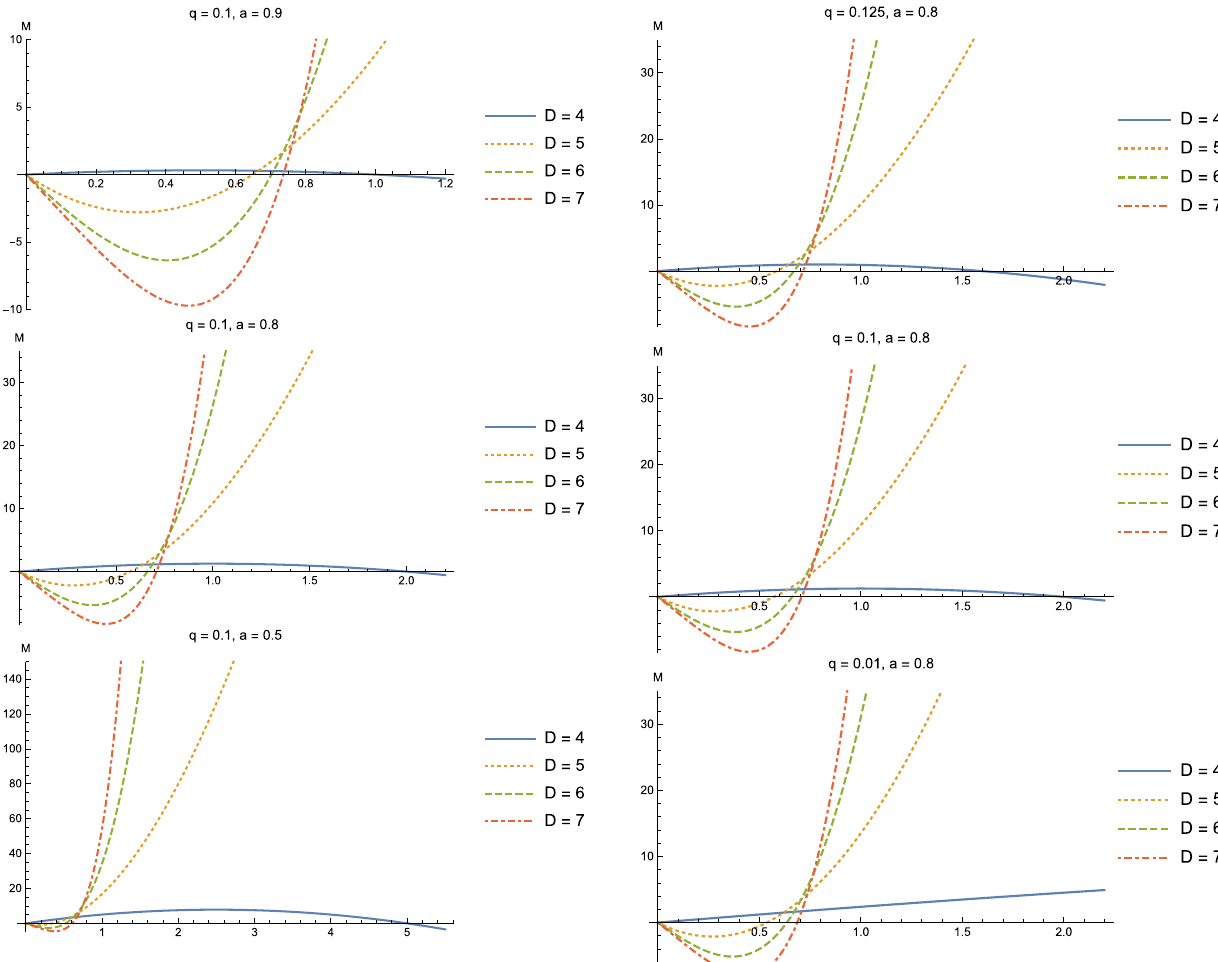
Fig. 5 Mass of black holes in D-dimensional TGR as a function of r h for different values of a as in the case of TGR in 4-dimensions.